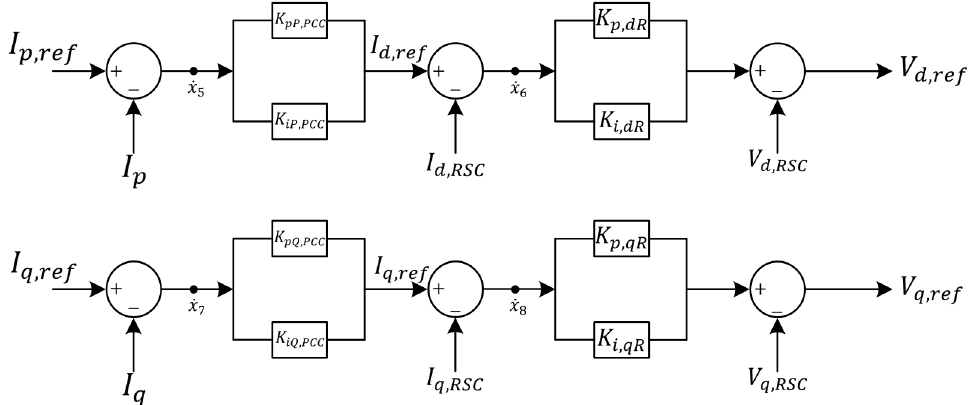
Figure 9. Machine-side converter control of a WTG T3 + T4.